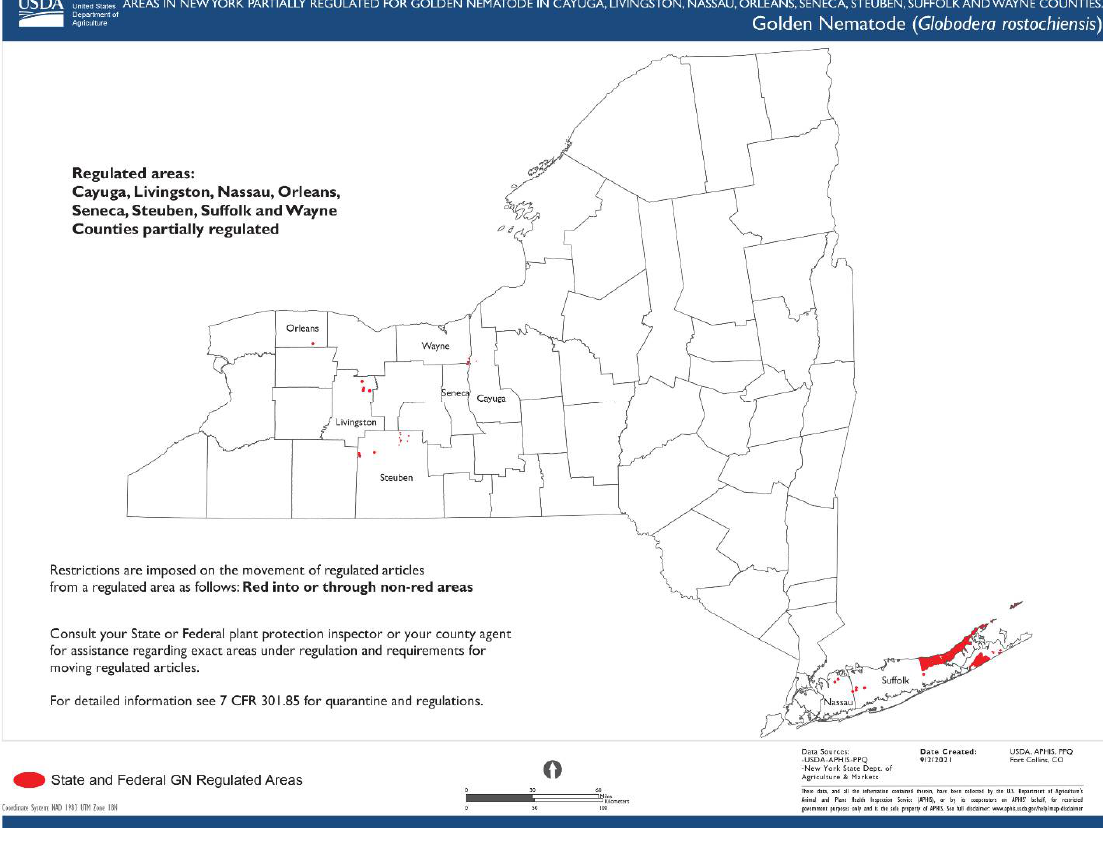
Figure 5. Continental U.S. distribution of Globodera rostochiensis (source, USDA, APHIS).